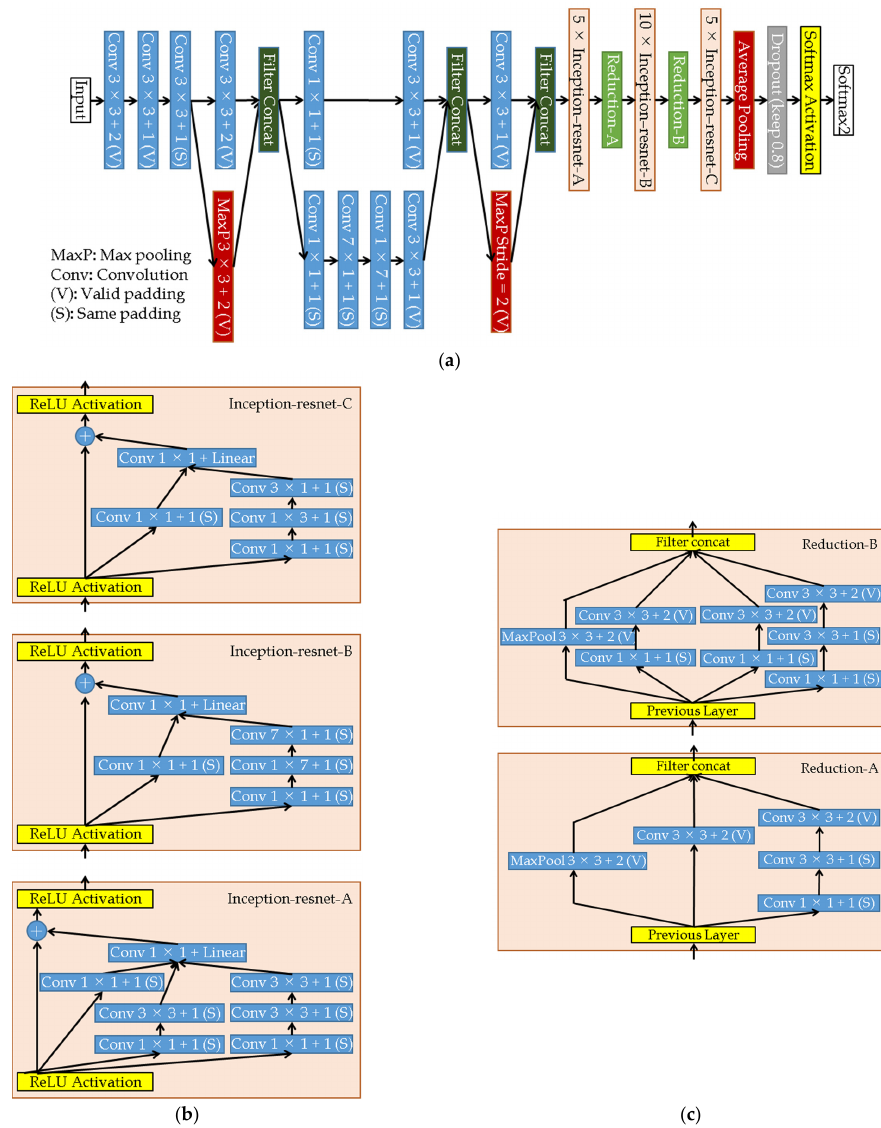
Figure A1. Schematic of Inception-ResNet-v2 architecture [22] referred to in our previous paper [16]: ( a ) overall network; ( b ) Inception-Resnet blocks: “-A” is repeated five times, “-B” is ten times, and “C” is five times; ( c ) Reduction-A and Reduction-B.